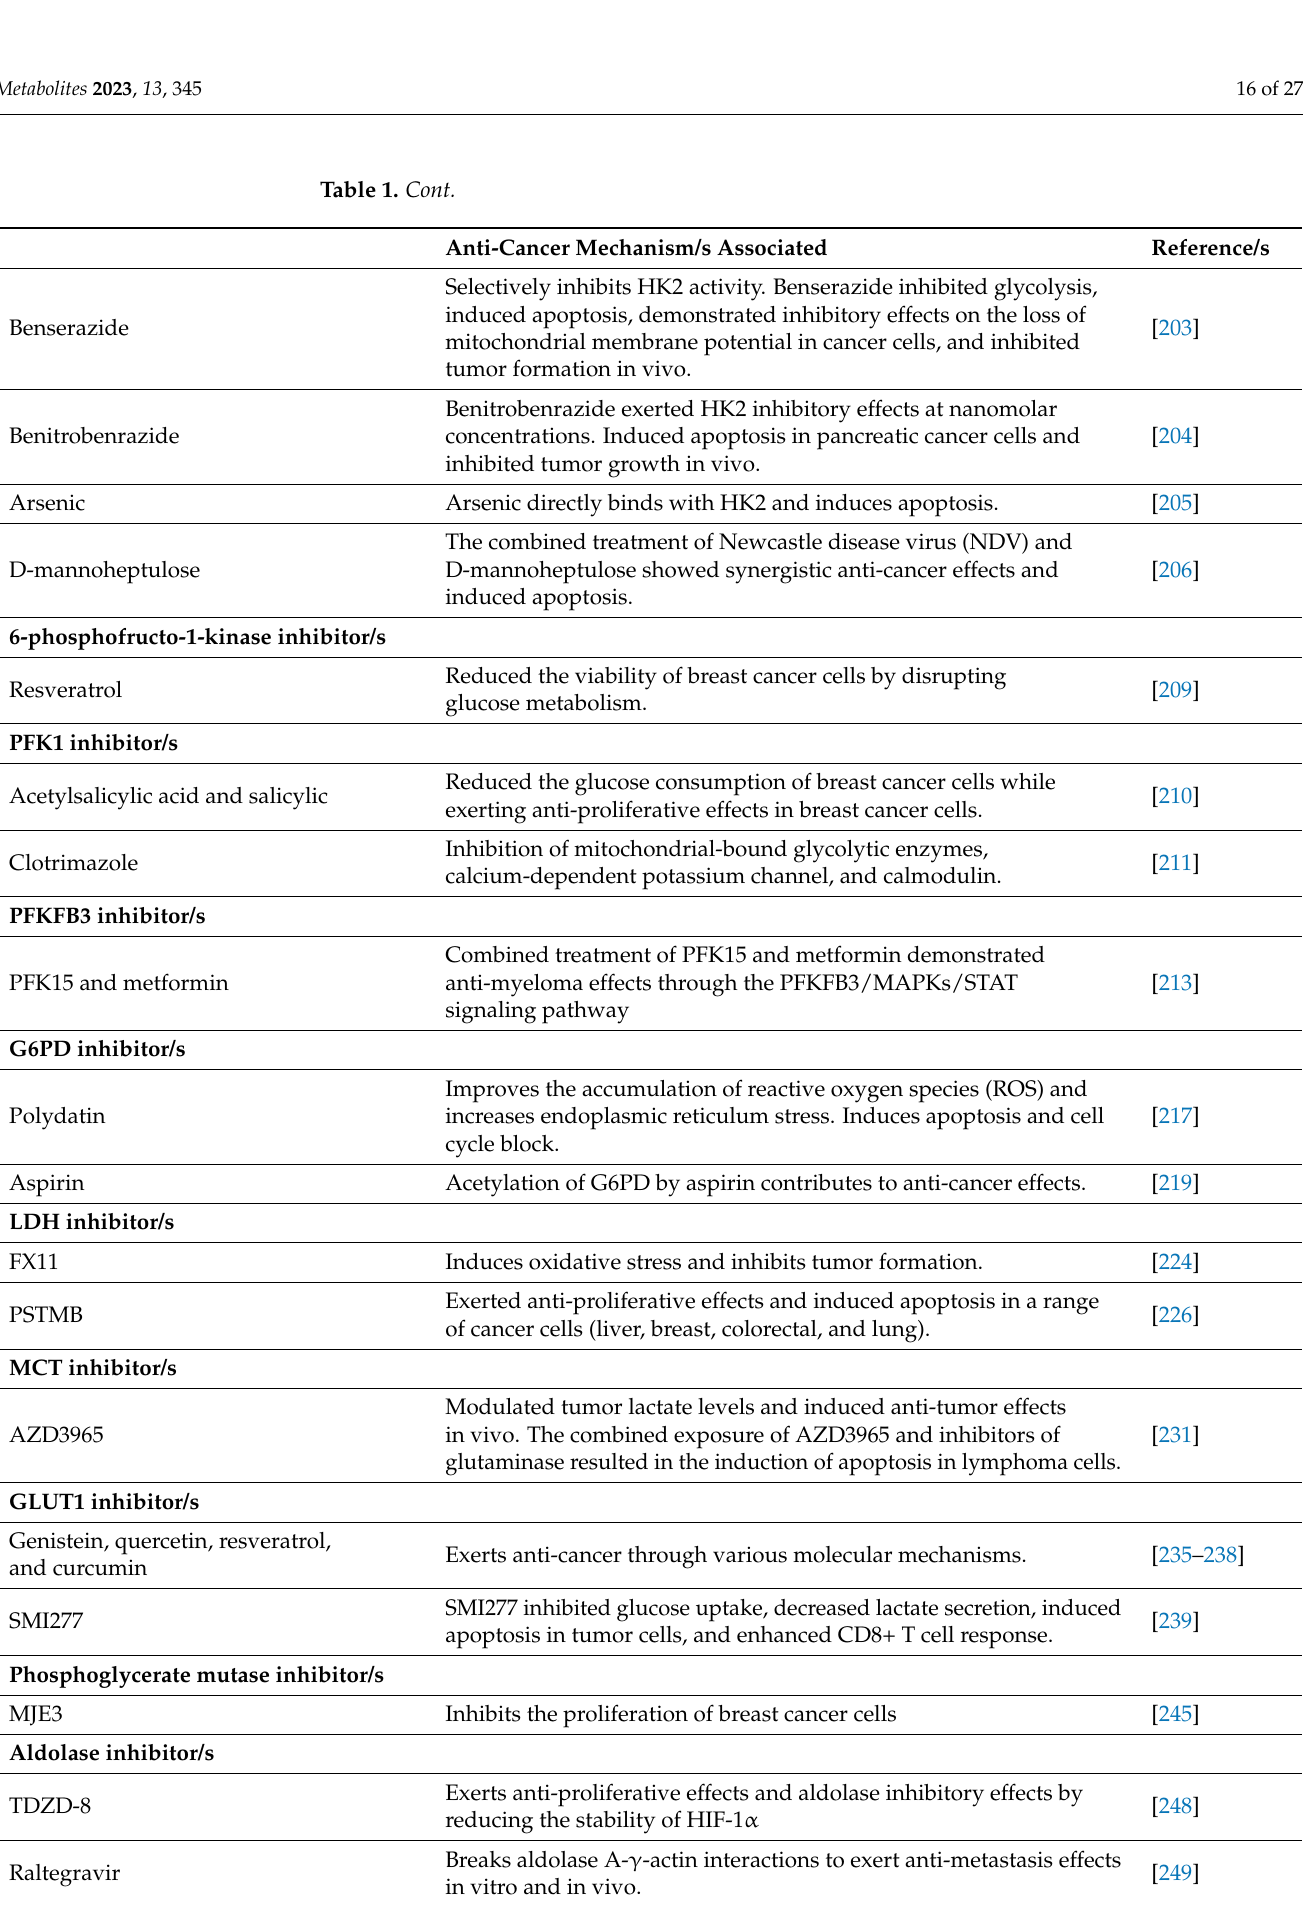
Table 1. Cont. Anti-Cancer Mechanism/s Associated